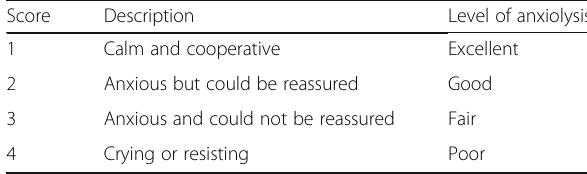
Table 4 Mask Acceptance Scale (Mountain et al.,